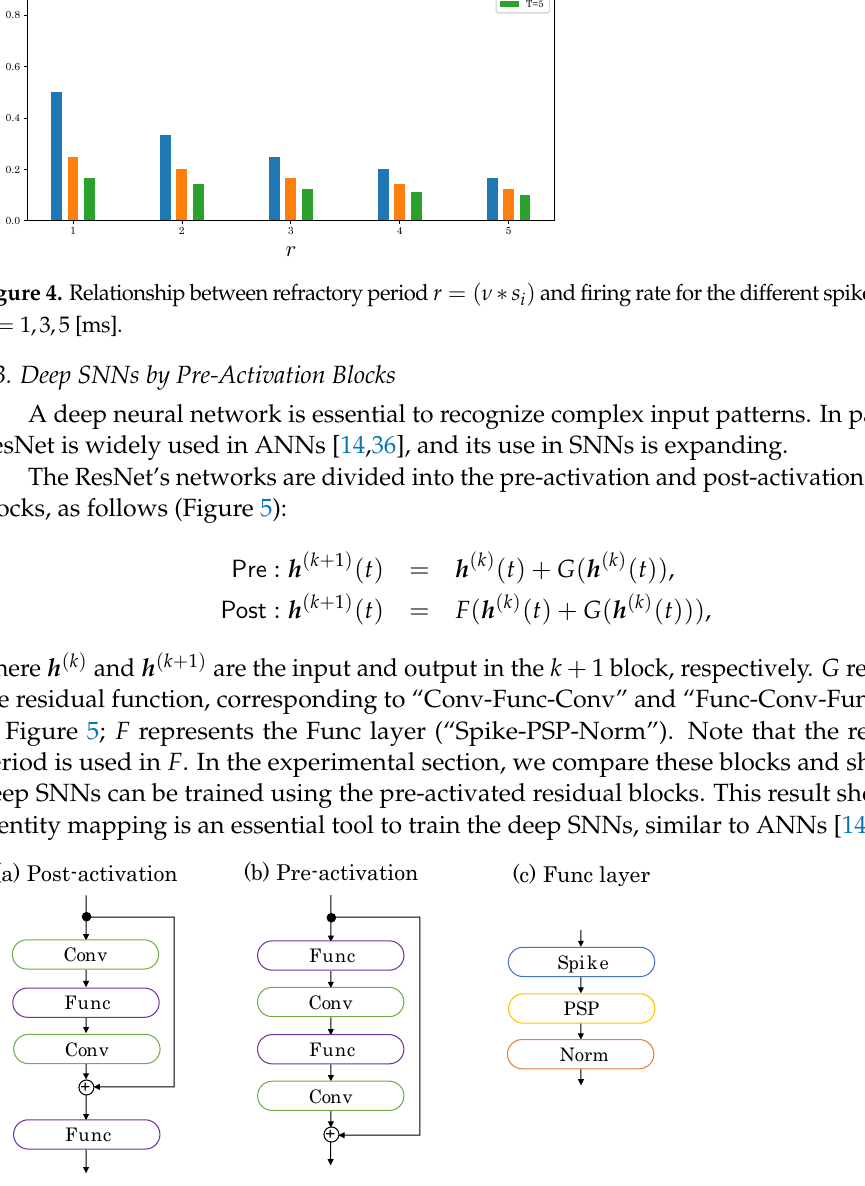
s i ) and firing rate for the different spike intervals ∗